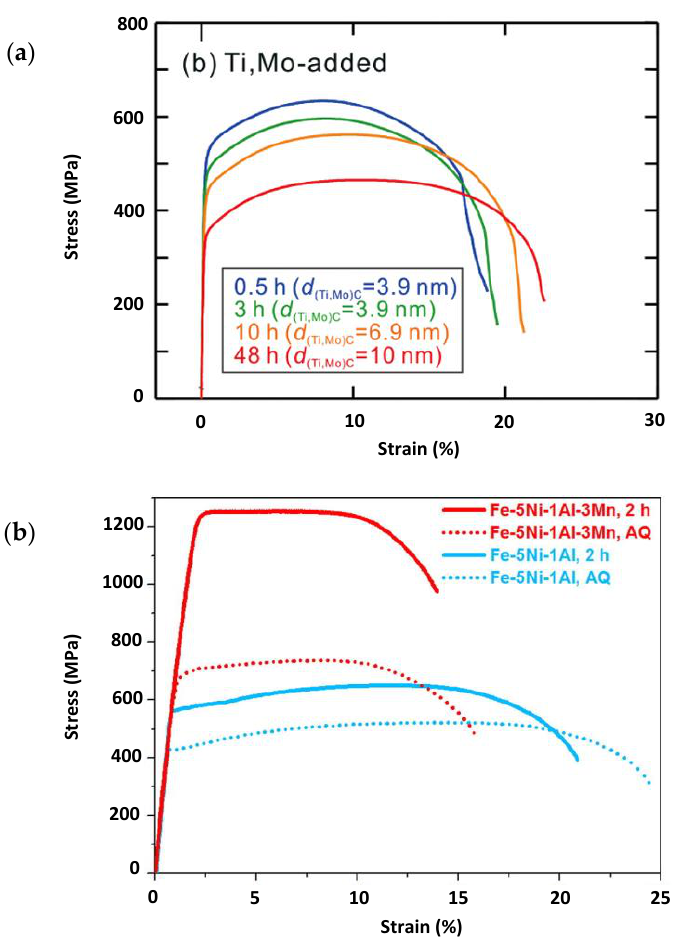
Figure 7. Stress-strain curves of steels strengthened by ( a ) Orowan looping [29] and ( b ) precipitate shearing mechanisms [2]. Work hardening, depicted by the gradual increase of stress up to the maximum stress level the steels can sustain before fracture, can be observed in steels strengthened by Orowan looping. Meanwhile, a flat plateau is normally observed in the steels that are dominated by precipitate shearing mechanism.